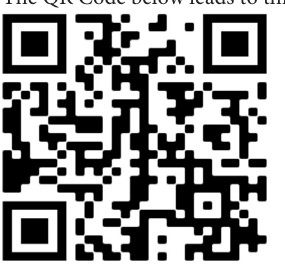
FIGURE4 Here the icon array presents the same data as in Figure 2, but they have been sorted, so as to make computations of